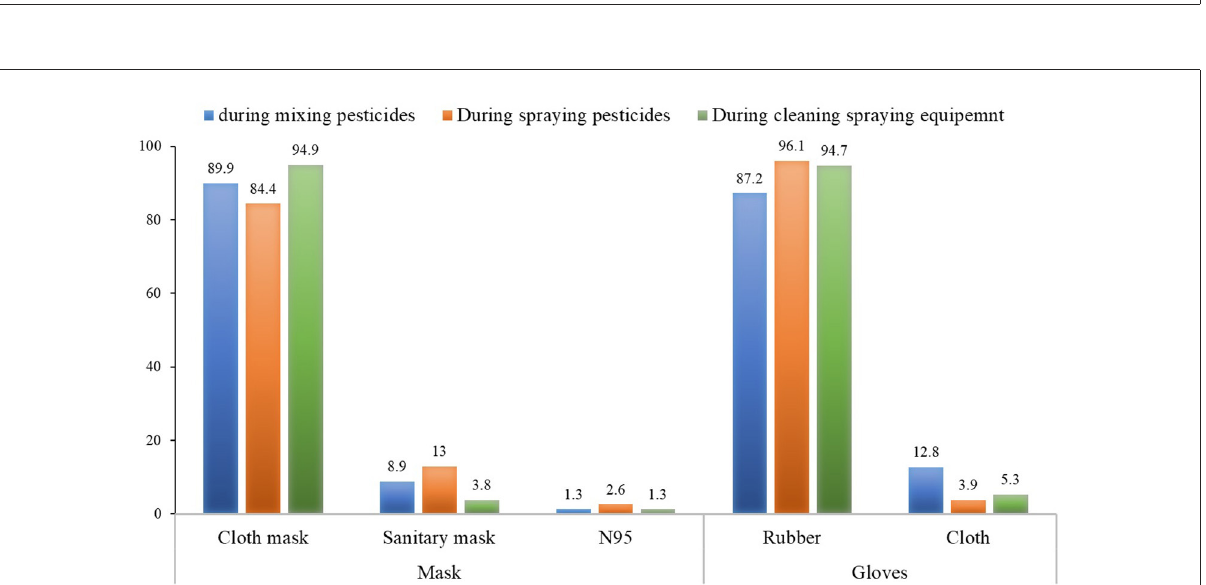
FIGURE2 Types of mask and gloves worn during pesticide